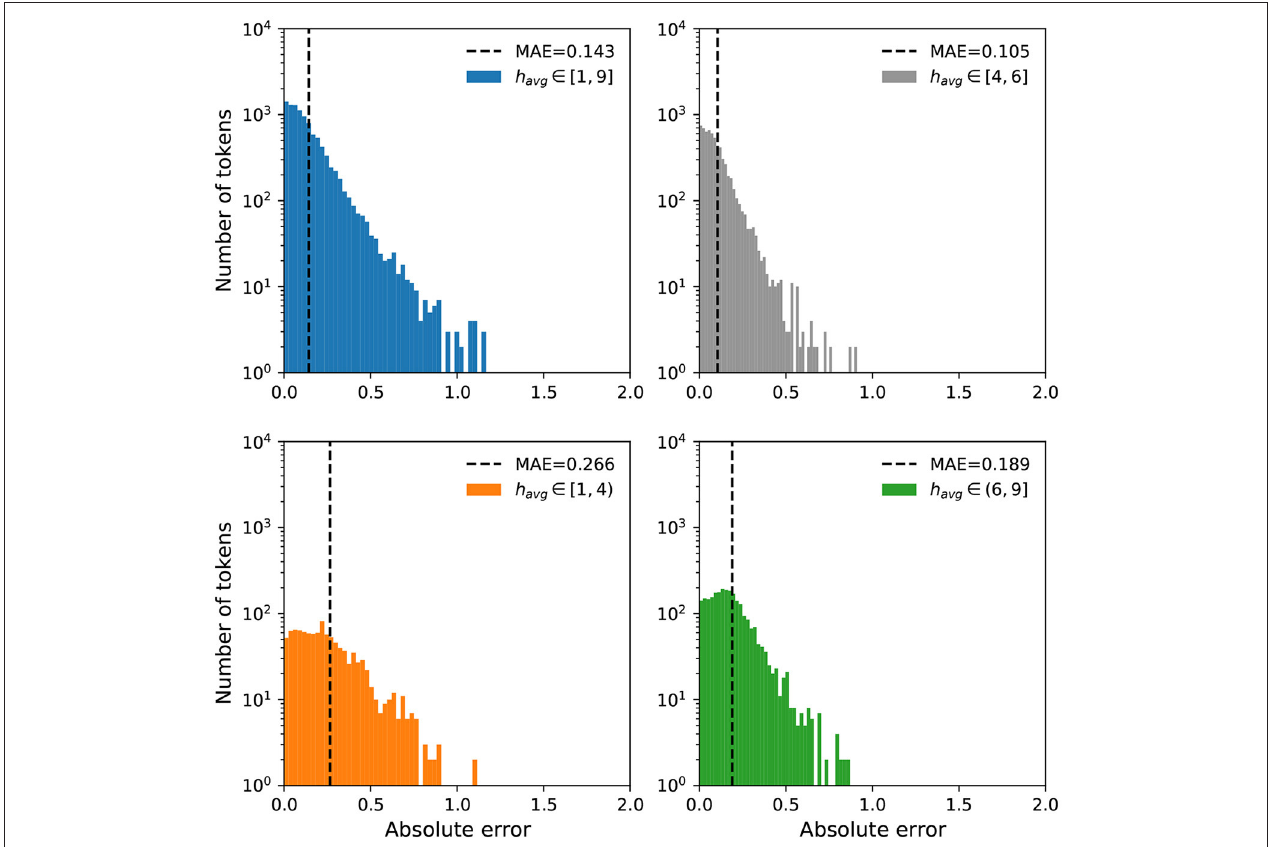
FIGURE 6 | Error distributions for the Dictionary model. We display mean absolute errors for predictions using the Dictionary model on all words in labMT. Again, we categorize the happiness scores into three groups: negative ( h avg ∈ [1,4), orange), neutral ( h avg ∈ [4,6], gray), and positive ( h avg ∈ (6,9], green). Similar to the Token model, most words have an MAE less than 1 with the exception of a few outliers. While the Dictionary model outperforms the Token model, we still observe a higher MAE for negative and positive terms compared to neutral